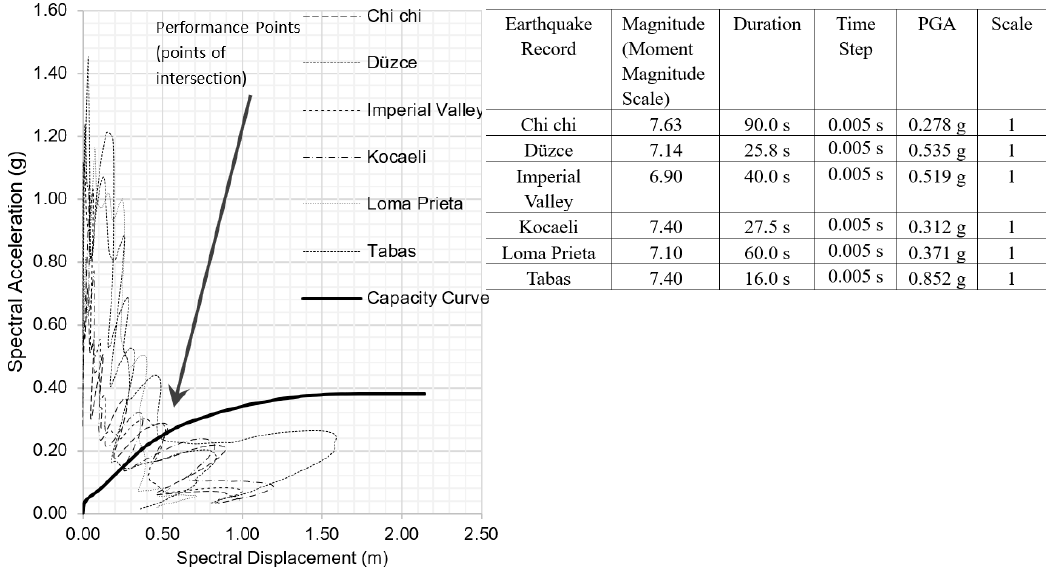
Figure 6. Outcome of the capacity spectrum analysis: 5% damped demand curves against the capacity curve [42].